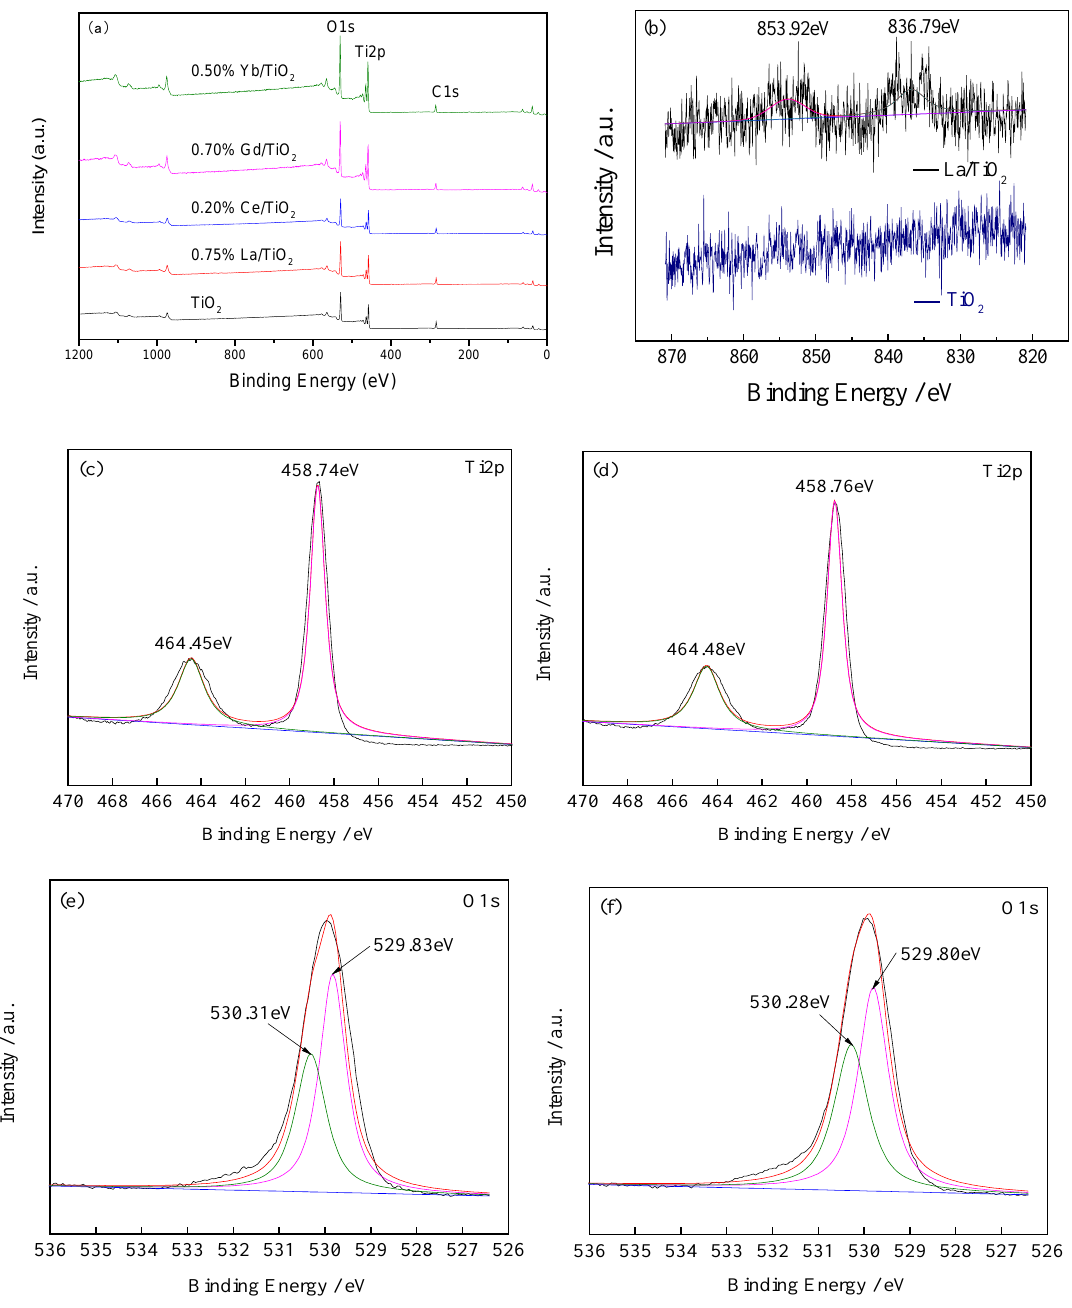
Figure 4. X-ray photoelectron spectroscopy (XPS) of RE/TiO 2 . ( a ) Full XPS scan of RE/TiO 2 ; ( b ) La3d; ( c ) Ti2p in pure TiO 2 ; ( d ) Ti2p in Gd/TiO 2 ( e ) O1s in pure TiO 2 ; ( f ) O1s in Gd/TiO 2 .